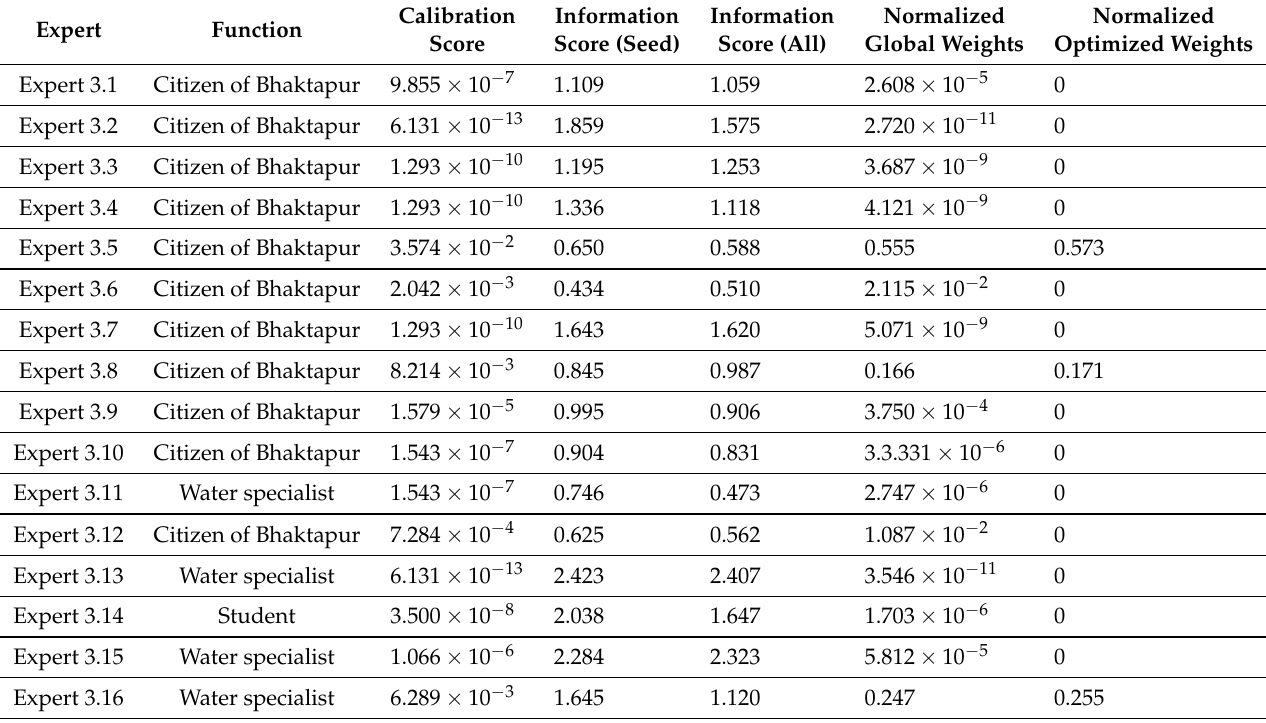
Table A4. Calibration and Information scores for the experts of panel